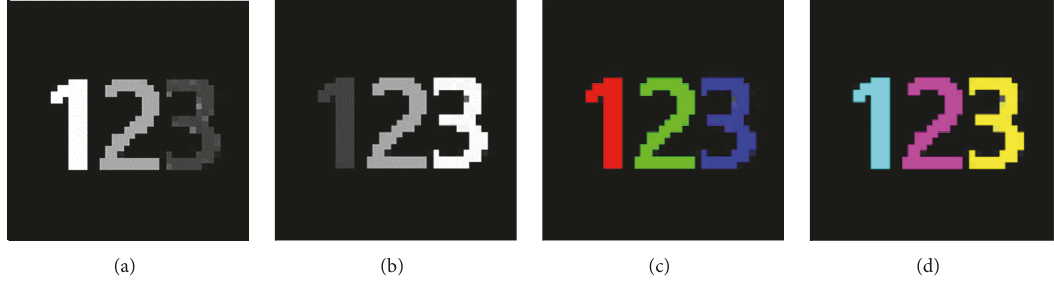
Figure 3: Various grey levels and colours of digits (CVs). Wavelet coeff. (A.U.)